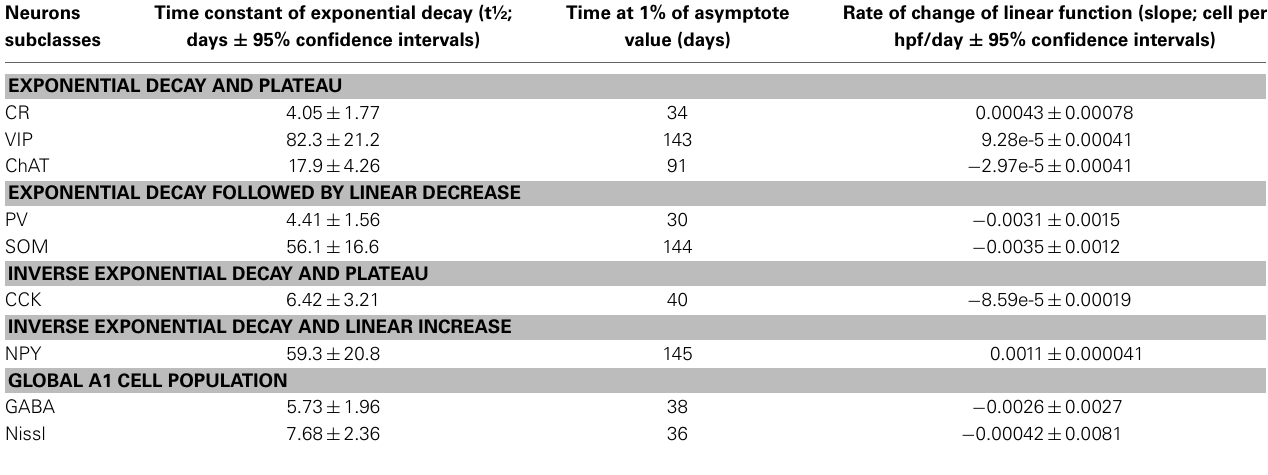
Table 3 | Summary of the main characteristics of all functions describing the trajectory of the neural markers examined.